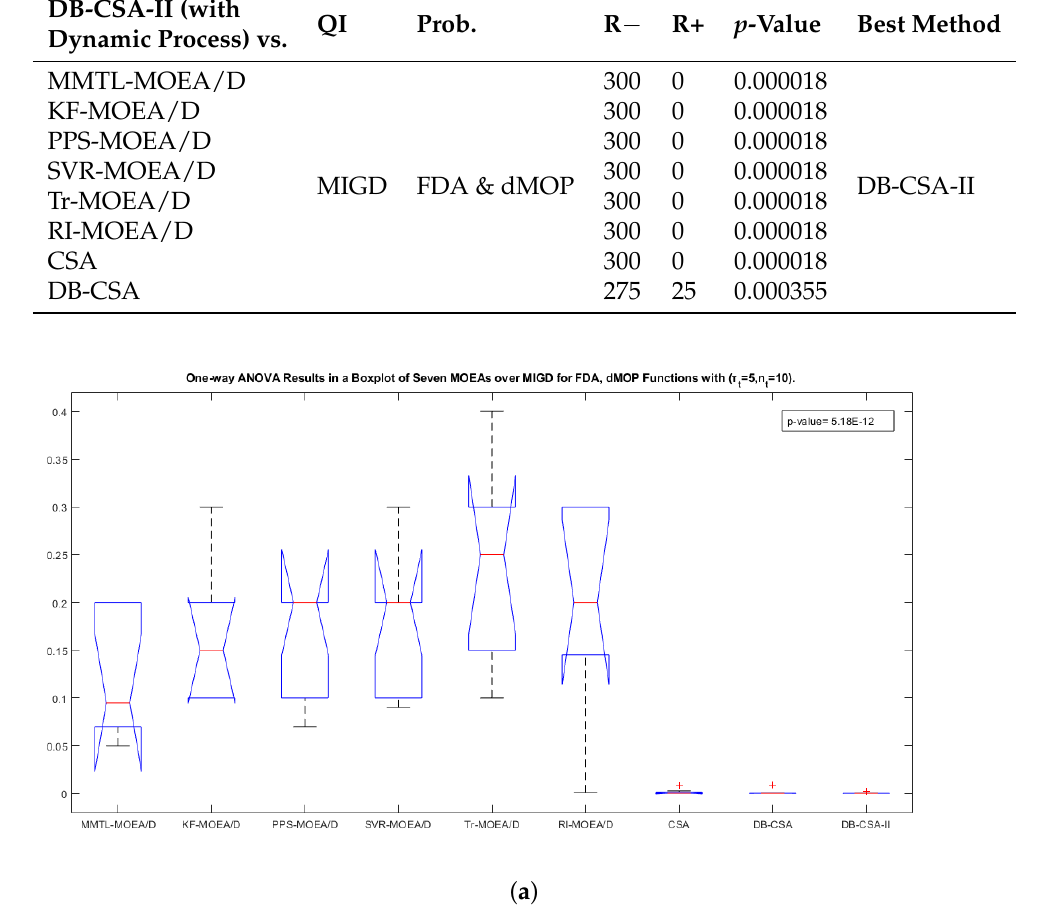
Table 8. Non-parametric statistical analysis based on a Wilcoxon signed rank test of DB-CSA-II vs. six peer transfer-learning based approaches over MIGD metric for FDA and dMOP functions. DB-CSA-II (with QI Prob. R − R+ p -Value Best Method Dynamic Process) vs.